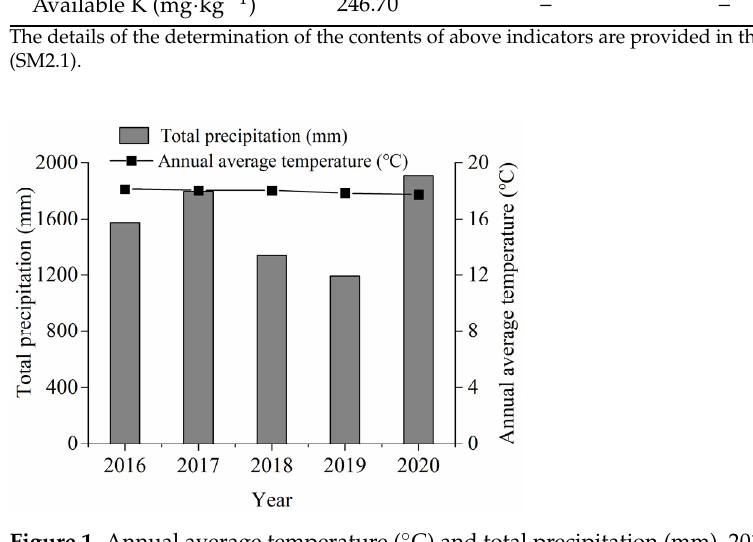
Figure 1. Annual average temperature ( ◦ C) and total precipitation (mm), 2016–2020 (Data from local meteorological station).